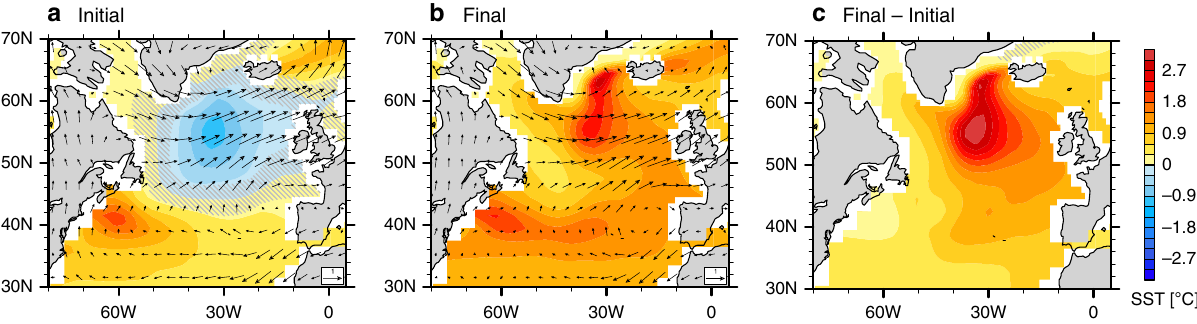
Fig. 6 The emergence and decay of the model North Atlantic warming hole (NAWH) in response to tropical Indian Ocean (TIO) warming. Anomalies in sea surface temperature (SST; units: °C) and surface winds (units: m s − 1 ) for the TIO + 1C experiment with respect to the pre-industrial (PI) experiment, over the ( a ) initial period, ( b ) fi nal period, and ( c ) the difference. “ Initial ” refers to Years 1 – 40, while “ fi nal ” refers to Years 151 – 200. Anomalies in panels ( a ) and ( c ) are considered parts of the system ’ s fast and slow responses in the North Atlantic, respectively. Gray hatches highlight the areas of lower statistical signi fi cance ( p -values of Student ’ s t test above